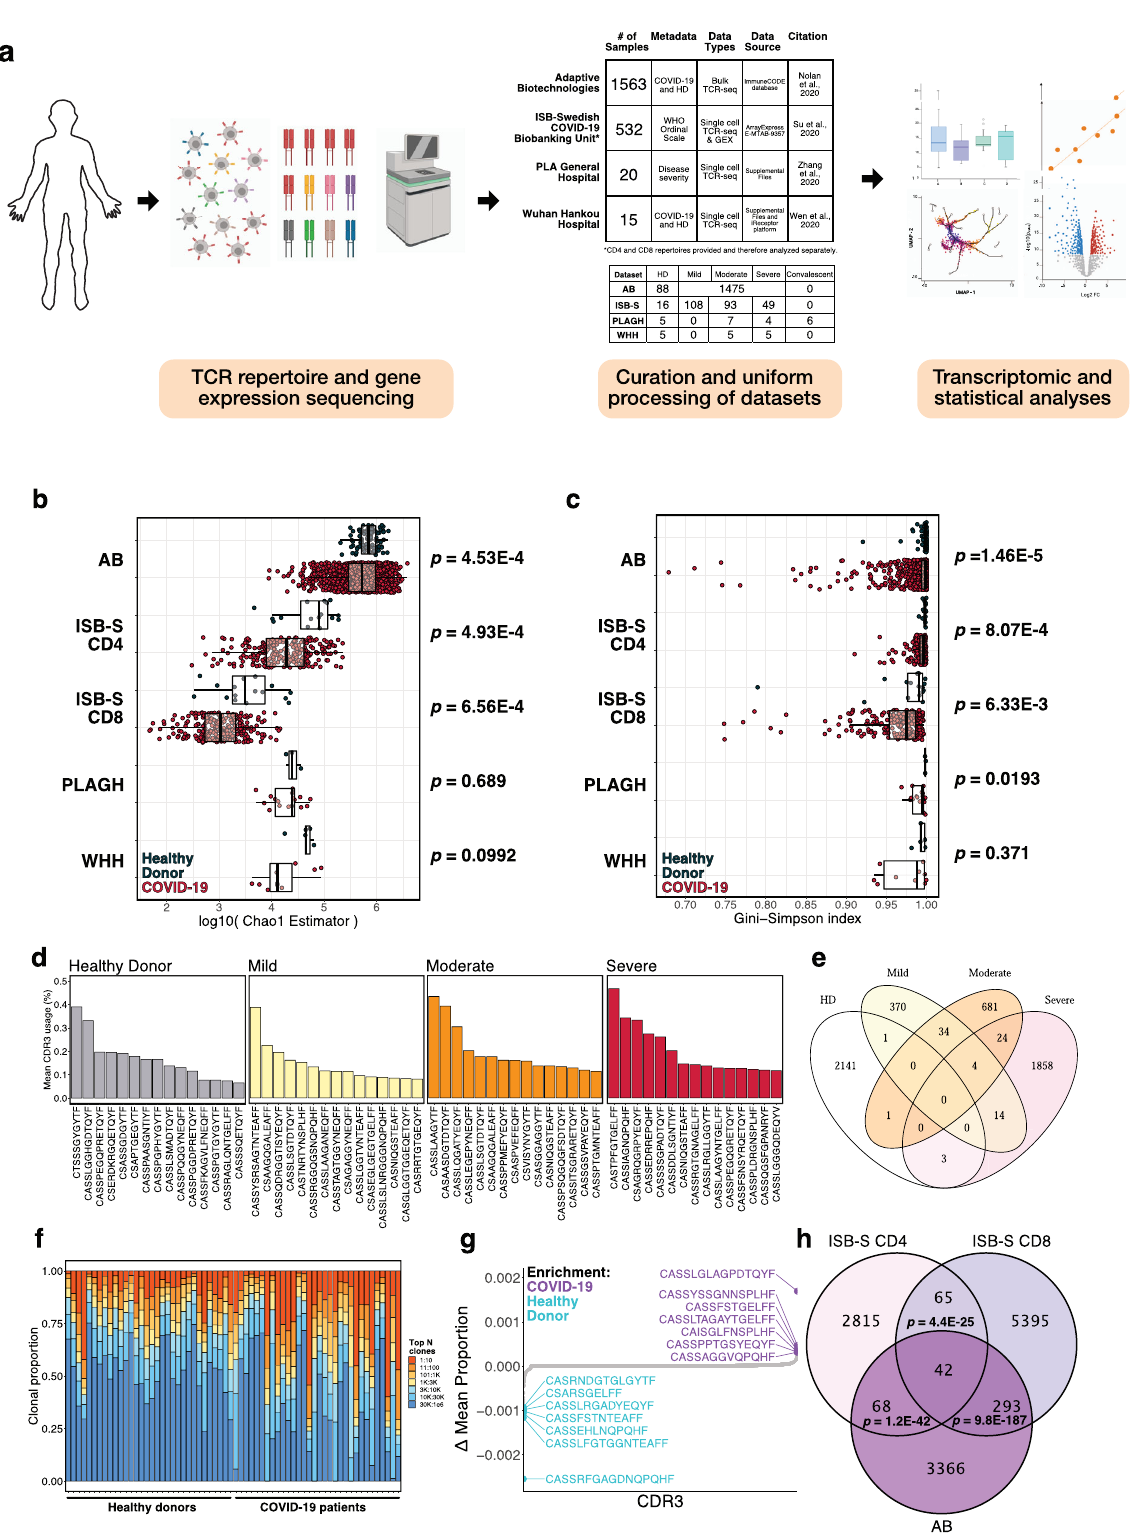
(Fig. S1D, E, Supplementary Dataset S5, S6), fewer differences in these gene usages were observed from the ISB-S datasets (Fig. S2A – D). Moreover, there were no differences in clonotype frequencies by CDR3 length across the datasets (Fig.